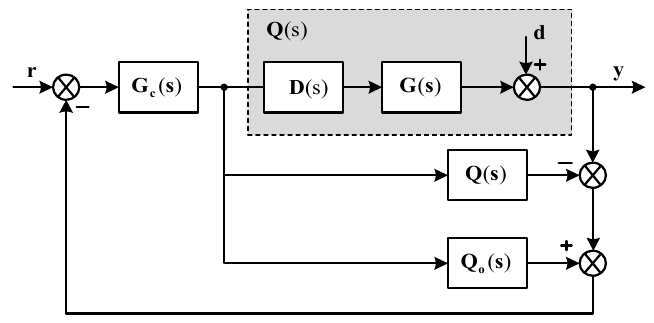
Figure 2. Decoupling SP (DSP) control system.